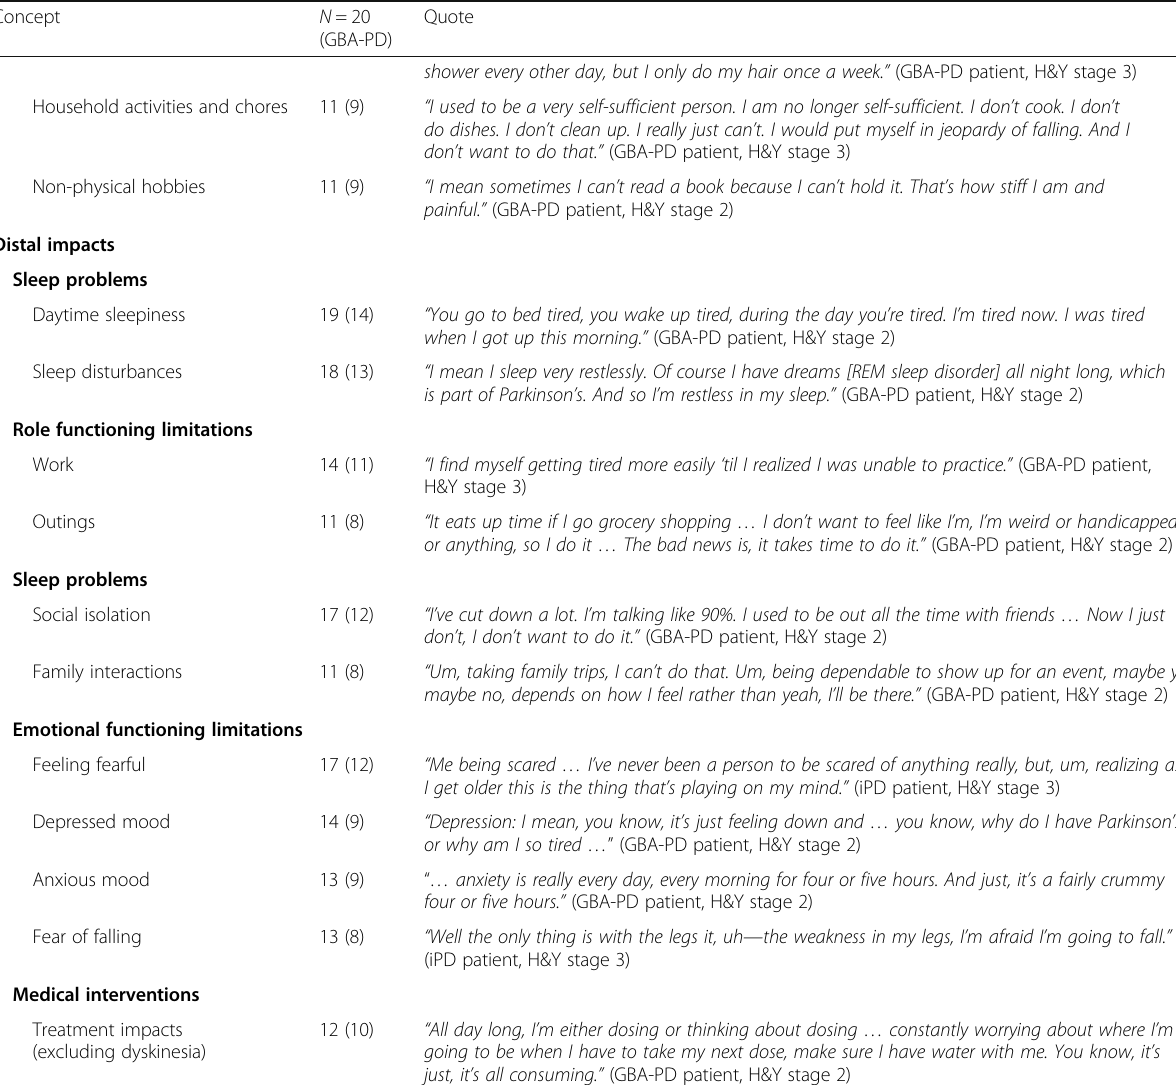
Table 3 Patient-reported ‘ most bothersome symptoms ’ and ‘ symptoms most important to treat ’ (Continued)